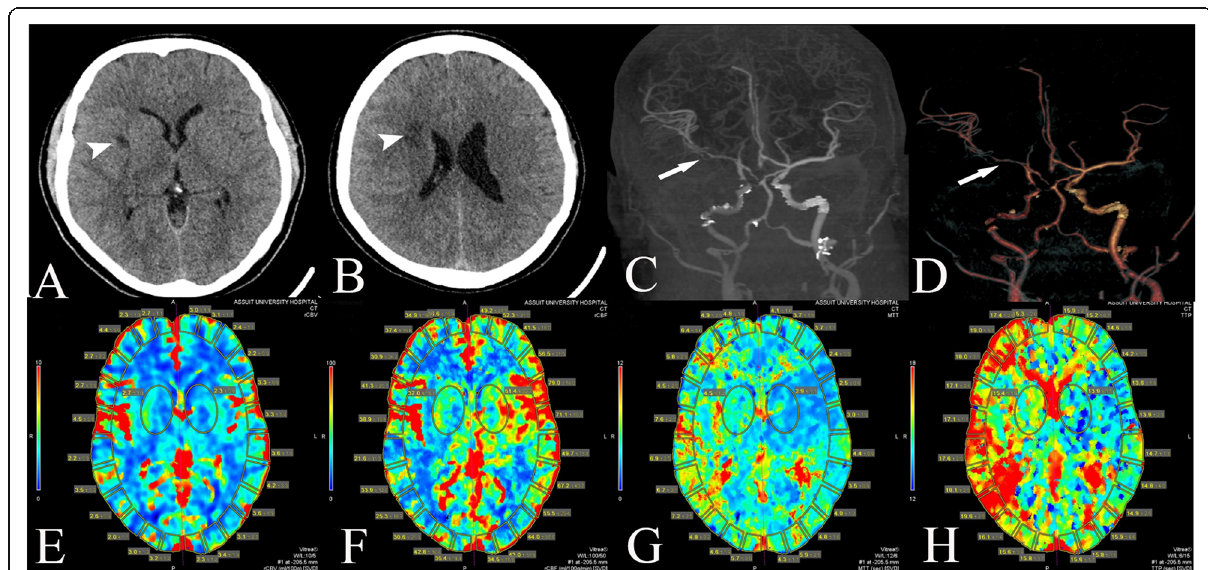
Fig. 4 On follow-up after 10 days, the patient developed left-sided hemiparesis and confusion. Non-contrast CT ( a , b ) shows multiple infarcts involving the right lentiform nucleus (asterisk in a ) and right frontal periventricular white matter (asterisk in b ). MIP ( c ) and volume rendering ( d ) images of CTA show severe vasospasm of the right MCA segments M1 and M2 (arrows in c and d ) as well as the right ACA segment A1. CT perfusion maps show significant perfusion deficit at the right side; reduced CBV ( e ), reduced CBF ( f ), prolonged MTT ( g ), and prolonged TTP ( h )